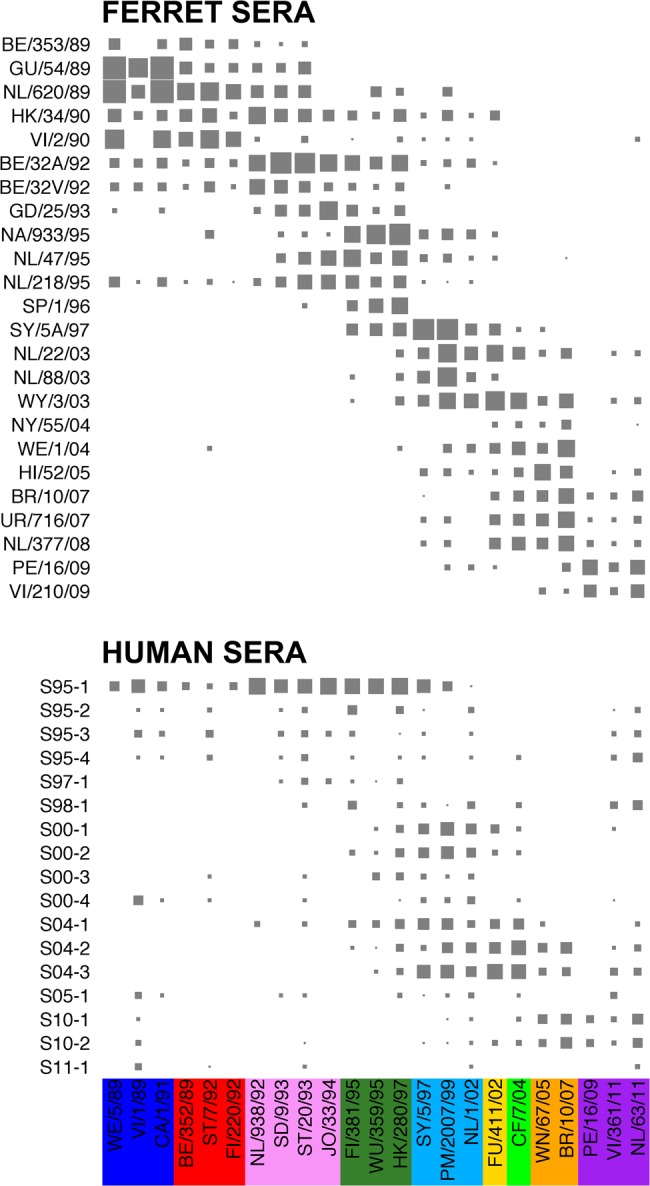
The measured hemagglutination inhibition (HI) titer with an increasing symbol size (<10 are size 0) for the ferret sera (top) and human sera (bottom), sorted by the year of isolation of the infecting virus and the year of serum collection, respectively, against the viruses sorted by their antigenic cluster. Different antigenic clusters are indicated with different colors, as follows: blue, Sichuan-87 cluster; red, Beijing-89 cluster; pink, Beijing-92 cluster; dark green, Wuhan-95 cluster; light blue, Sydney-97 cluster; yellow, Fuijan-02 cluster; light green, California-04 cluster; orange, Brisbane-07 cluster; and purple, Perth-09 cluster. See also Supplementary Data Sets 2 and 3.